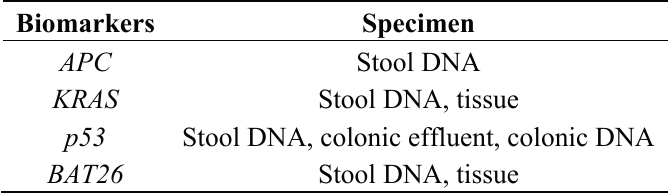
Table 2. Genetic biomarkers in colorectal cancer